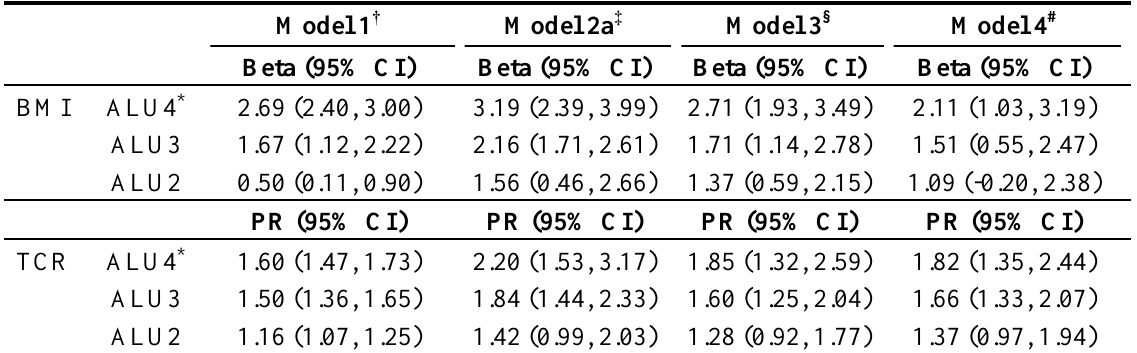
Table 2. Associations between area-level unemployment, body mass index (BMI) and total cardiometabolic risk (TCR) (n =